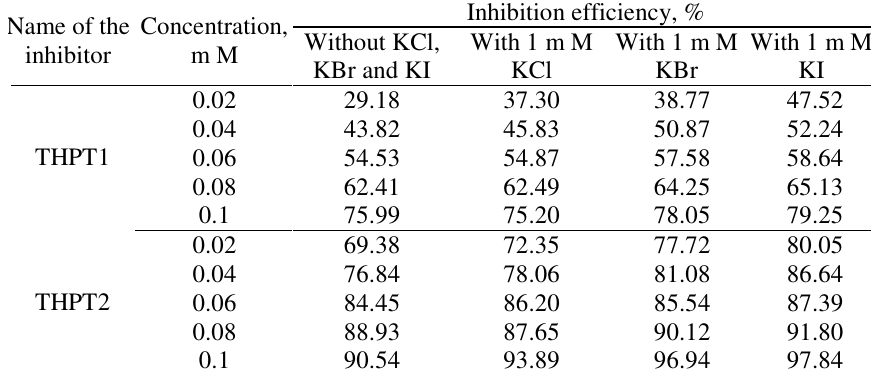
Inhibition efficiency, %